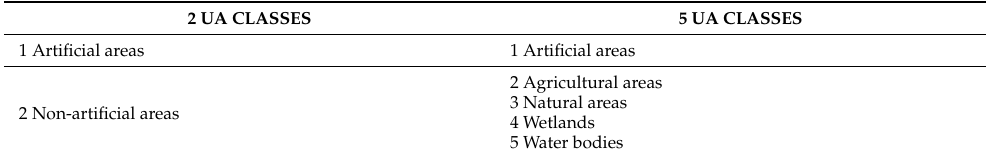
Table 1. Urban Atlas (UA) class